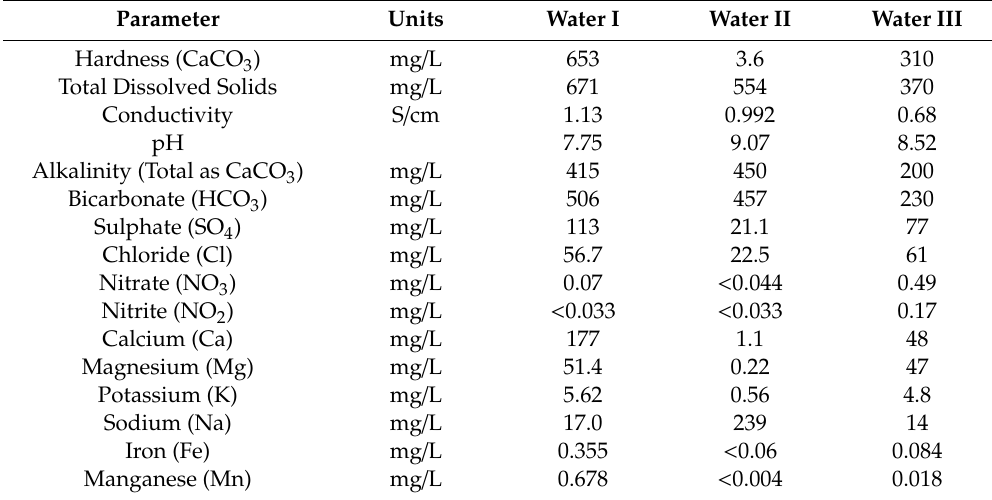
Table 1. Physical and chemical properties of groundwater: Water I was from a 12-m-deep groundwater well; Water II was from a 70-m-deep groundwater well, and Water III was from a 11-m-deep groundwater well, pretreated by activated carbon (provided by Bonavista Energy